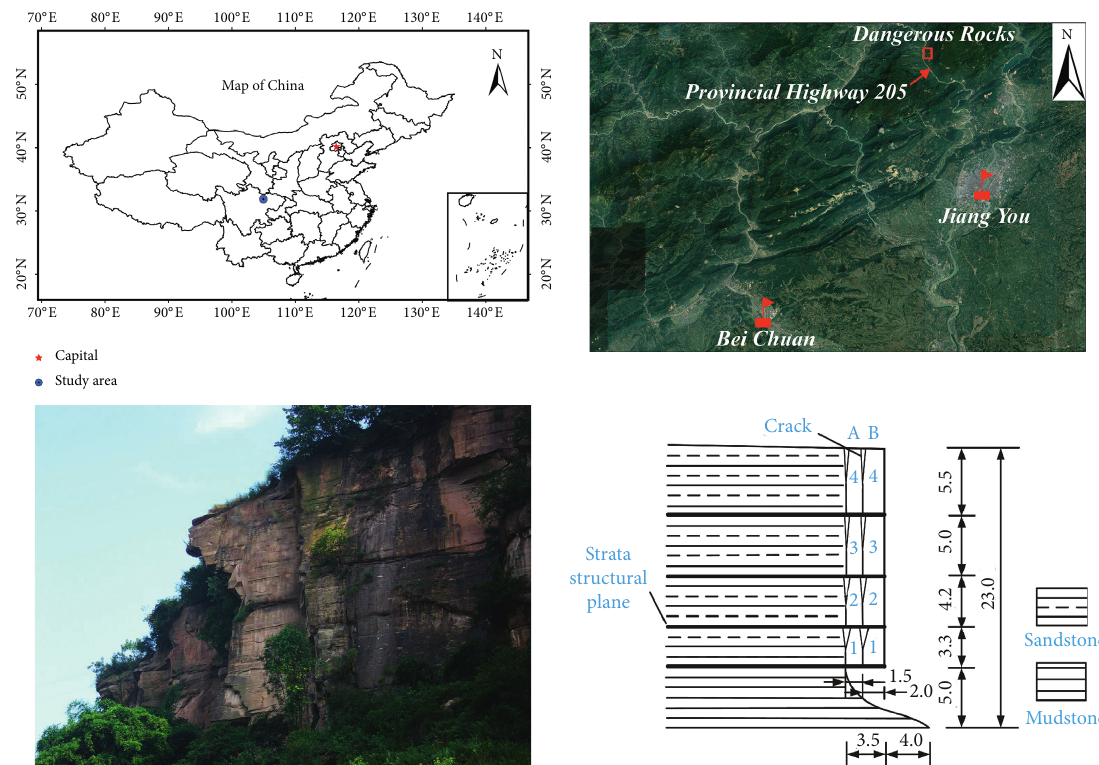
Figure 1: The real scene and geological model of the dangerous rock (unit: m). Table 1: Rock block and crack size table (unit: m).